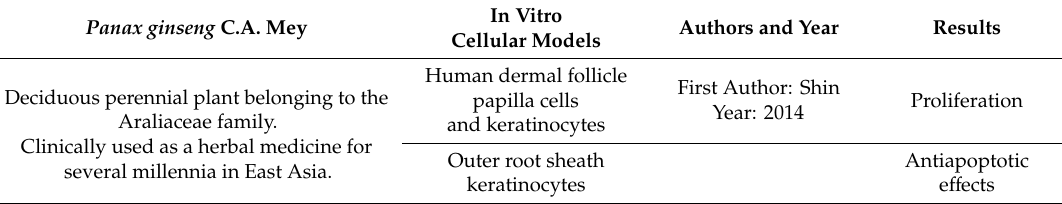
Table 1. Schematic representation of in vitro cellular models used to test the role of Panax ginseng C.A. Mey.